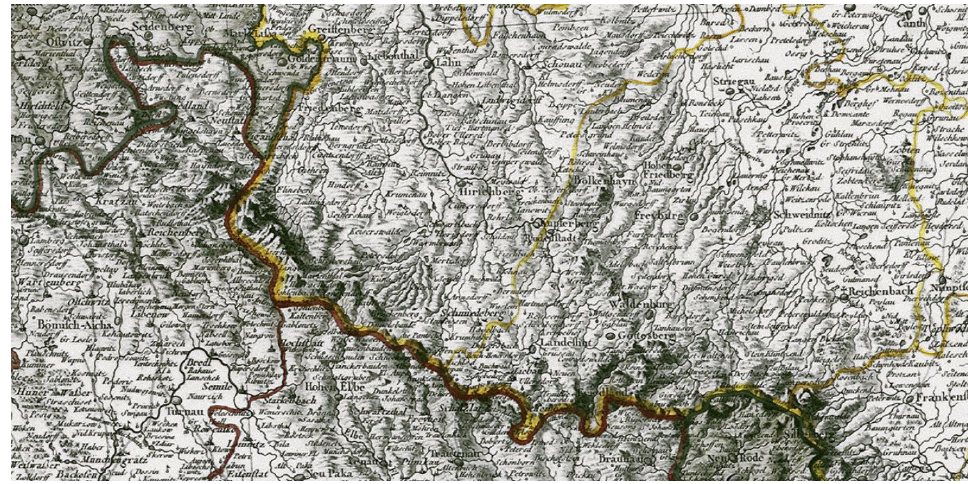
Fig. 6. Southwestern part of Silesia on Chauchard’s map from 1790. Relief presented mainly with semi-perspective. Hillocks with added peaks visible in Karkonosze